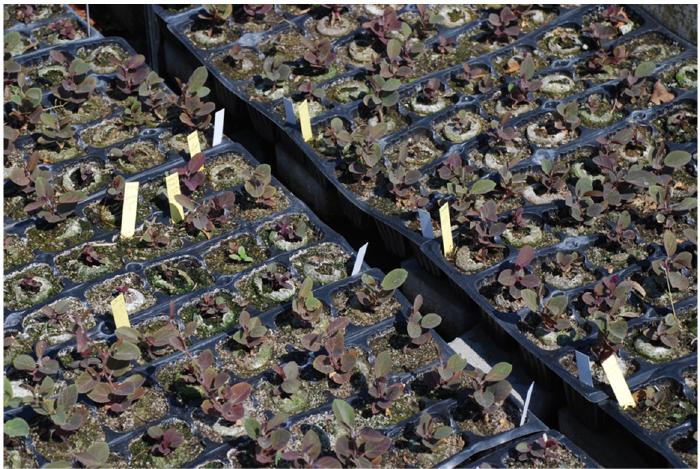
Figure 3. Experiments in seed propagation carried out in Spain at CITA by using seed of capers from Ballobar (Aragon, Spain) .